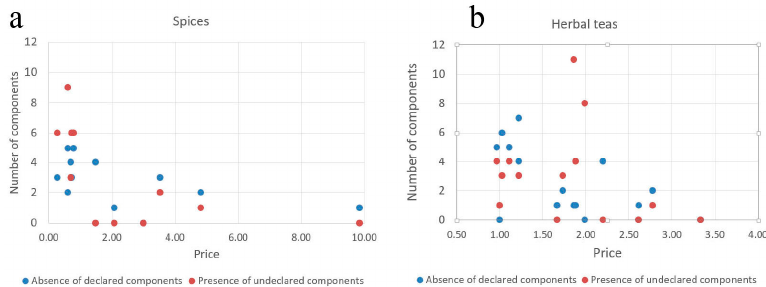
Figure 4. Scatterplot showing prices of the products and different types of deviation from the labelled content: absence of labelled components (blue dots) and presence of unlabelled (red dots). ( a ) Spices, ( b ) herbal teas (including group D, which includes herbal medicines, prepared and consumed in the same way as